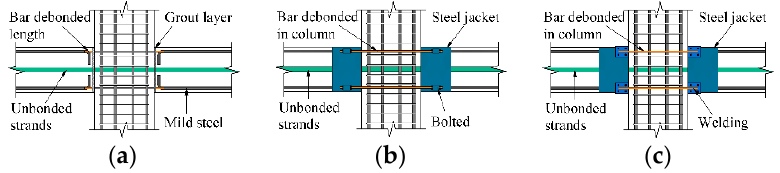
Figure 2. Non-emulated connection forms: ( a ) mild steel located inside the beam; ( b ) mild steel bolted to the beam side; ( c ) mild steel welded to the beam side.